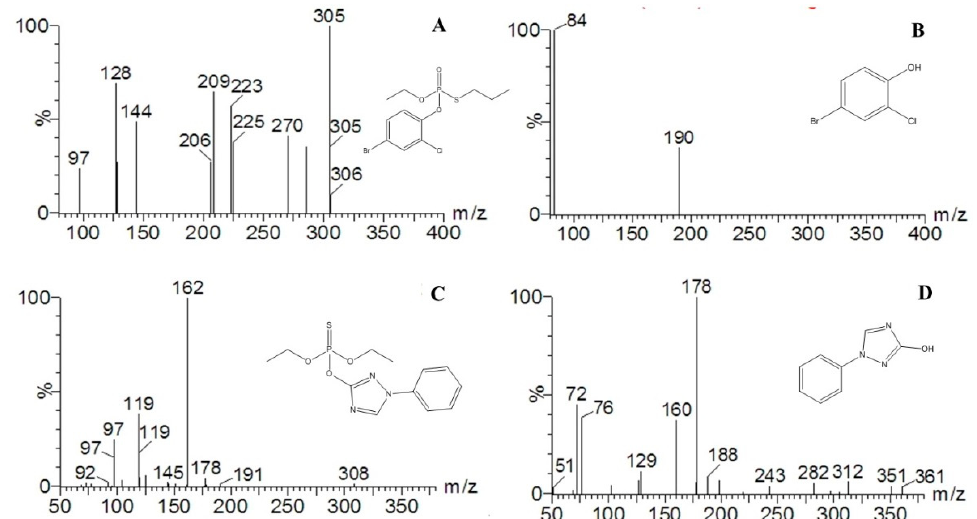
Figure 4. Mass spectra and structures of profenofos, triazophos and their degradation byproducts in B. chinensis in the presence of TiO 2 /Ce. ( A ) profenofos; ( B ) degradation byproduct of profenofos: 4-bromo-2-chlorophenol; ( C ) triazophos; and ( D ) degradation byproduct of triazophos: 1-phenyl-3-hydroxy-1, 2,4-triazole.